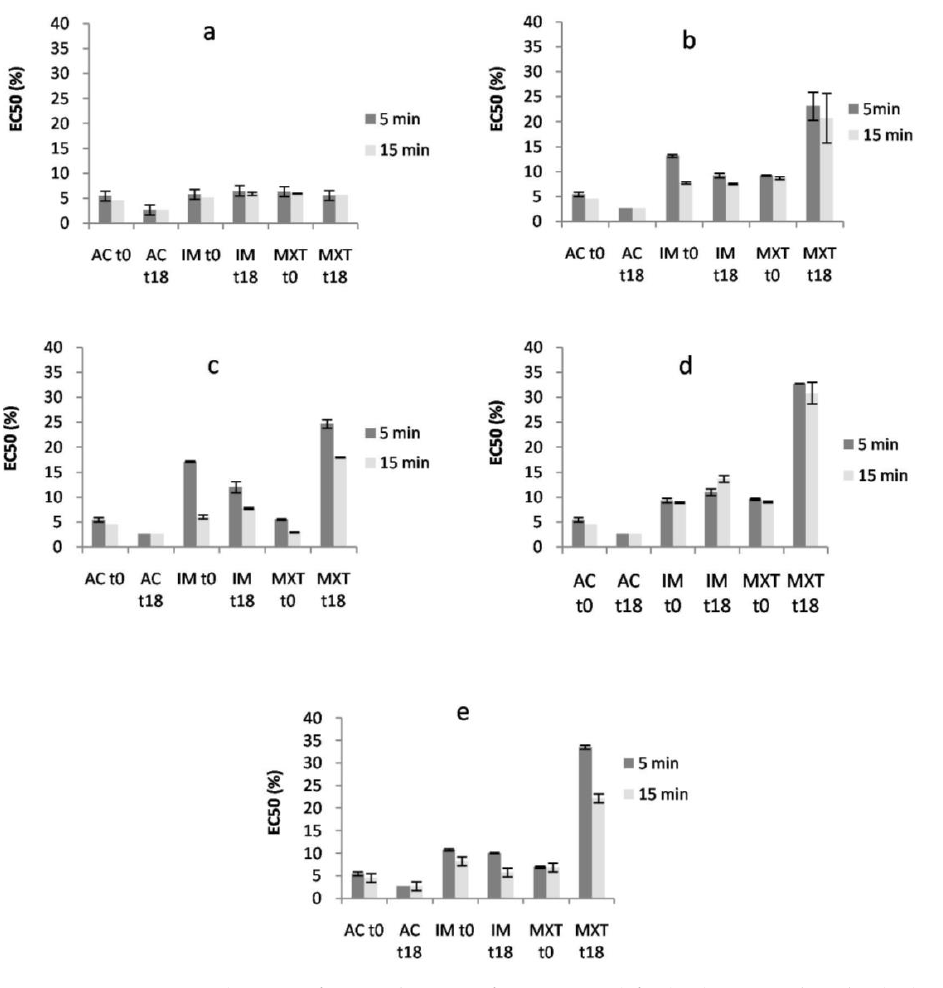
Figure 6. Acute toxicity (as EC 50 after 5 and 15 min after exposition) for (AC) untreated media, (IM), PAH and HM cultures treated with inactivate mycelia, and (MXT) treatment of PAH and HM culture media with live cells of ( a ) C. jodhpurense , ( b ) C. maderasense , ( c ) P. variabile , ( d ) E. lacerata , and ( e ) P. betae at time 0 and after 18 days of incubation. Error bars indicate the average of three replicates (n =